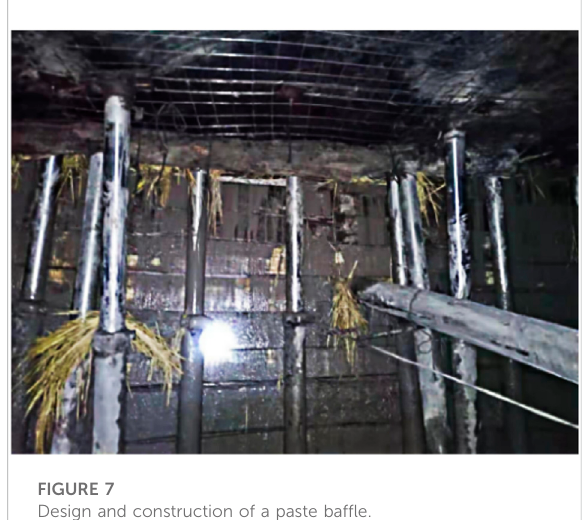
FIGURE 7 Design and construction of a paste baf fl